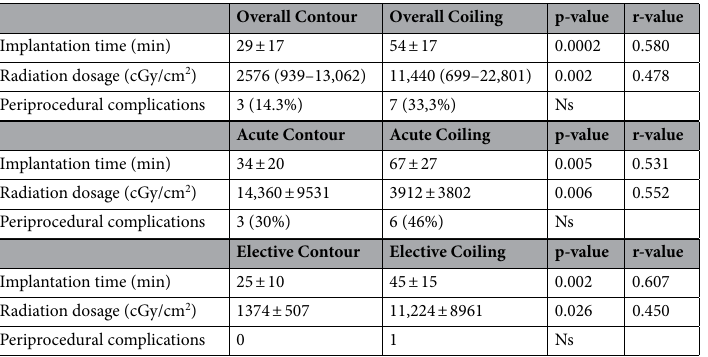
Table 2. Comparison of implantation time, radiation dose and periprocedural complications and overall and in both subgroups.